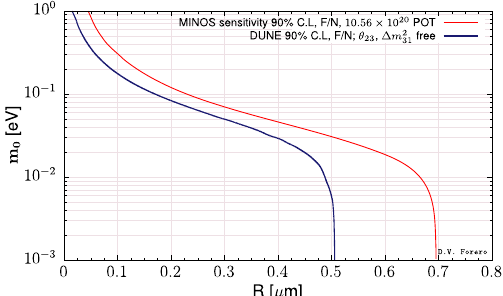
Fig. 39 Sensitivity to the LED model in Refs. [282–284] through its impact on the neutrino oscillations expected at DUNE. For